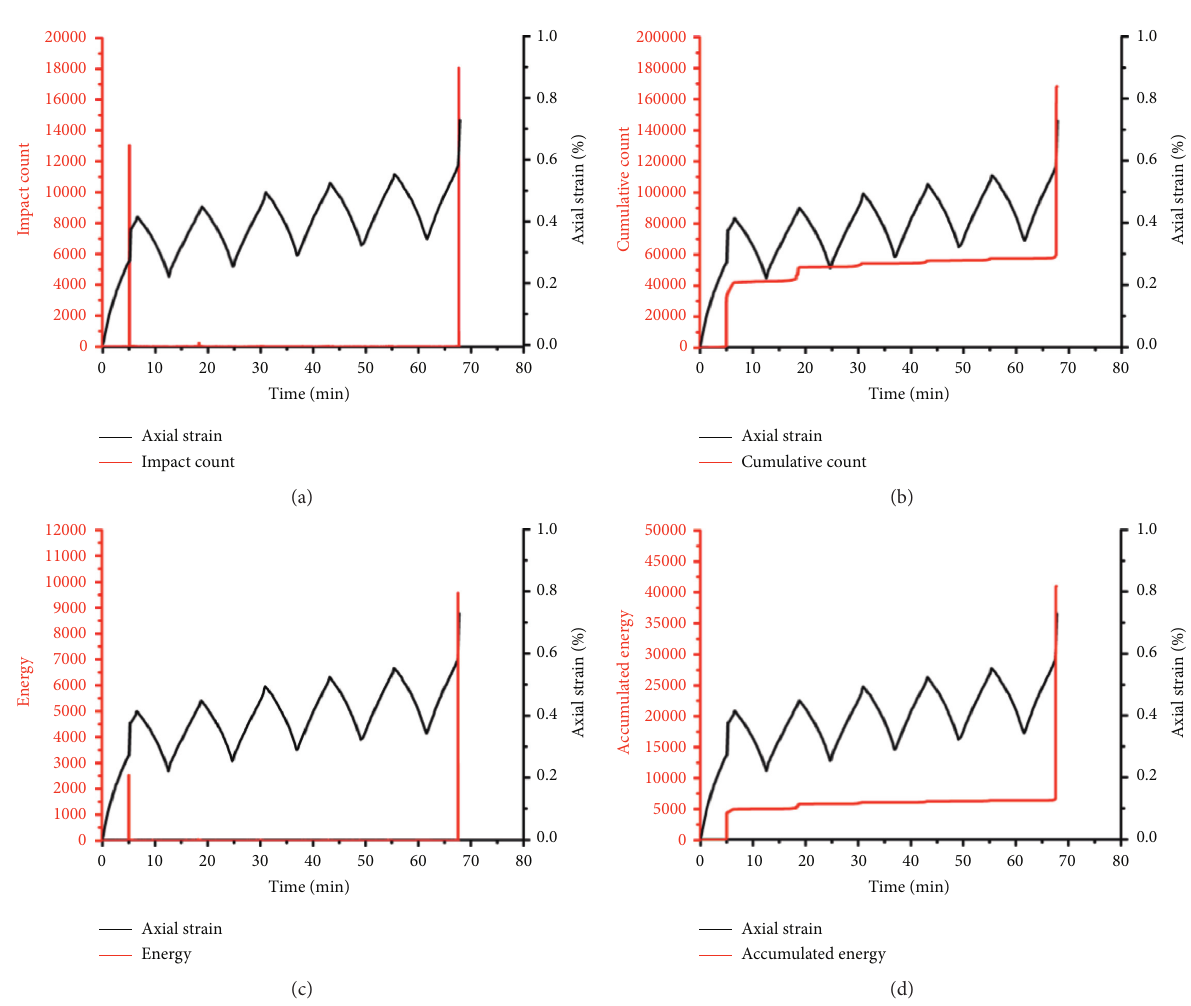
Figure 15: Deformation and acoustic emission characteristics of S-1-2 sample. (a) The curves of ringing count and axial strain of S-1-2 sample with time. (b) The curves of cumulative ringing count and axial strain of S-1-2 sample with time. (c) The curves of energy and axial strain of S-1-2 sample with time. (d) The curves of cumulative energy and axial strain of S-1-2 sample with